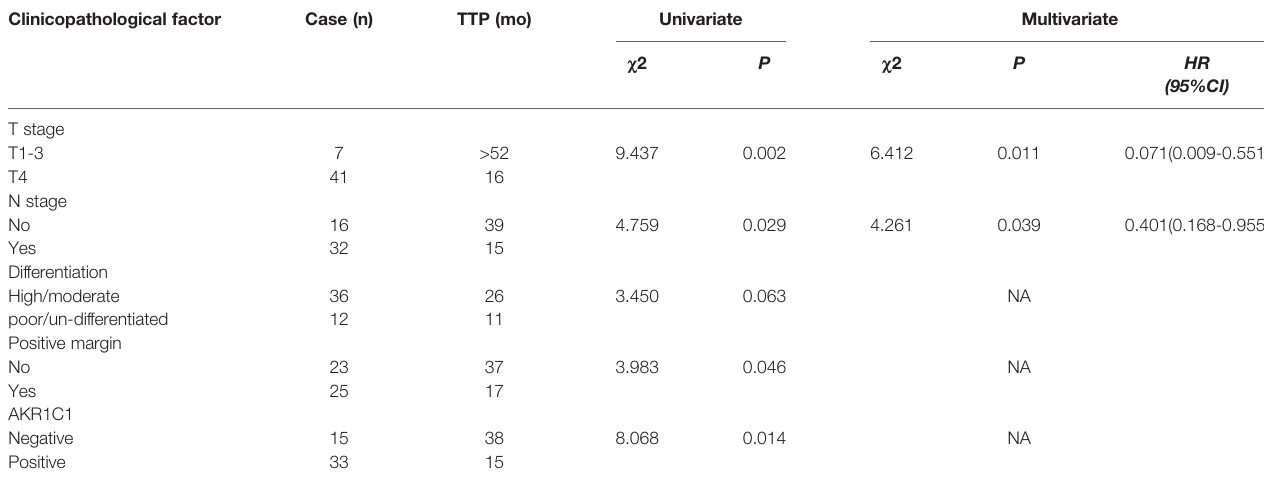
TABLE 2 | Univariate and multivariate analysis of time to progression in 49 patients with hilar cholangiocarcinoma according to clinicopathologic factors and AKR1C1 overexpression. Clinicopathological